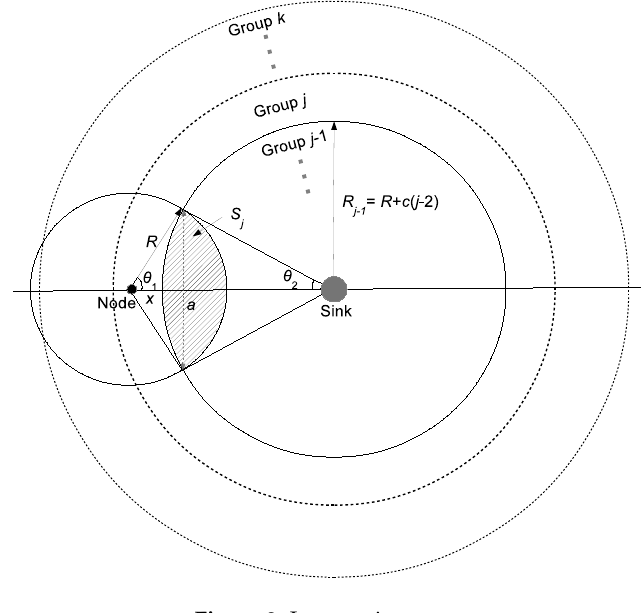
Figure 2. Intersection